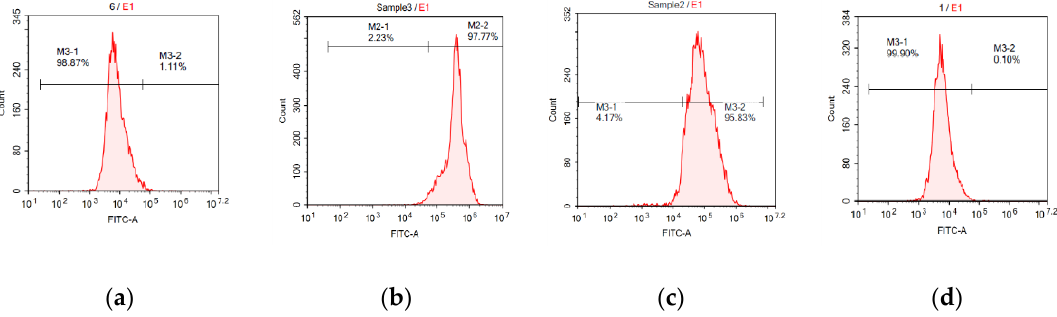
Figure 6. Flow cytometry analysis of labeled NTERA-2 cells incubated with ( a ) TbPO 4 ·H 2 O@silica- NH 2 ; ( b ) TMC , ( c ) CD133-FITC; and ( d ) negative control using a Novocyte flow cytometry system and NovoExpress software (ACEA Bioscience Inc.).